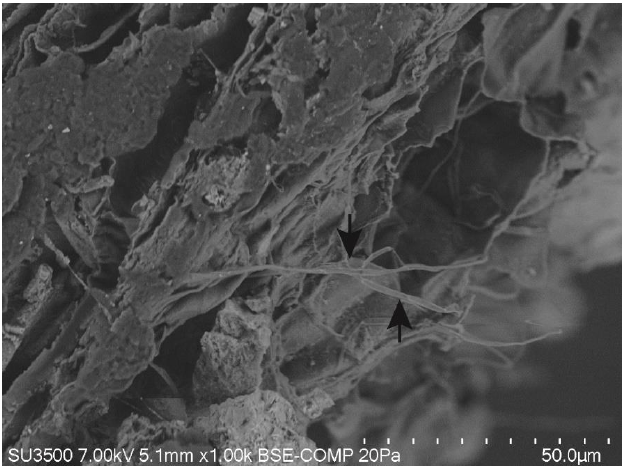
Figure 2. Detection of Chaetomium cupreum in roots of inoculated plants of Eucalyptus globulus (90 days post inoculation) observed under scanning electron microscopy. Black arrows show fungal hyphae.